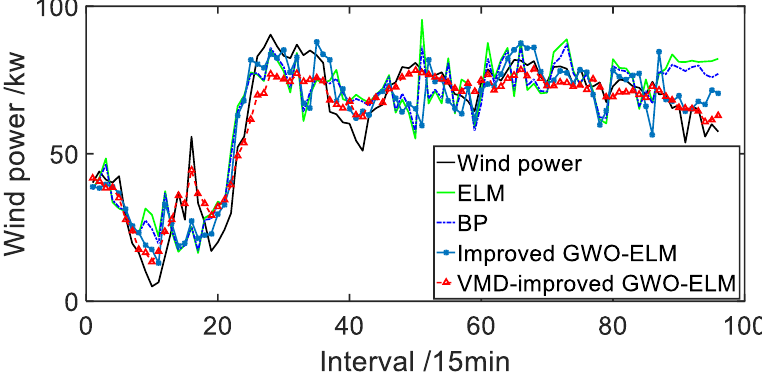
Figure 10. The comparison of different prediction results curve.